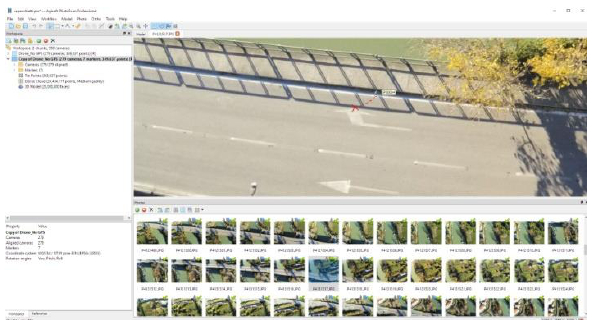
Figure 10: a detailed view of how different the point taken with GPS and the result of the drone cloud differ.